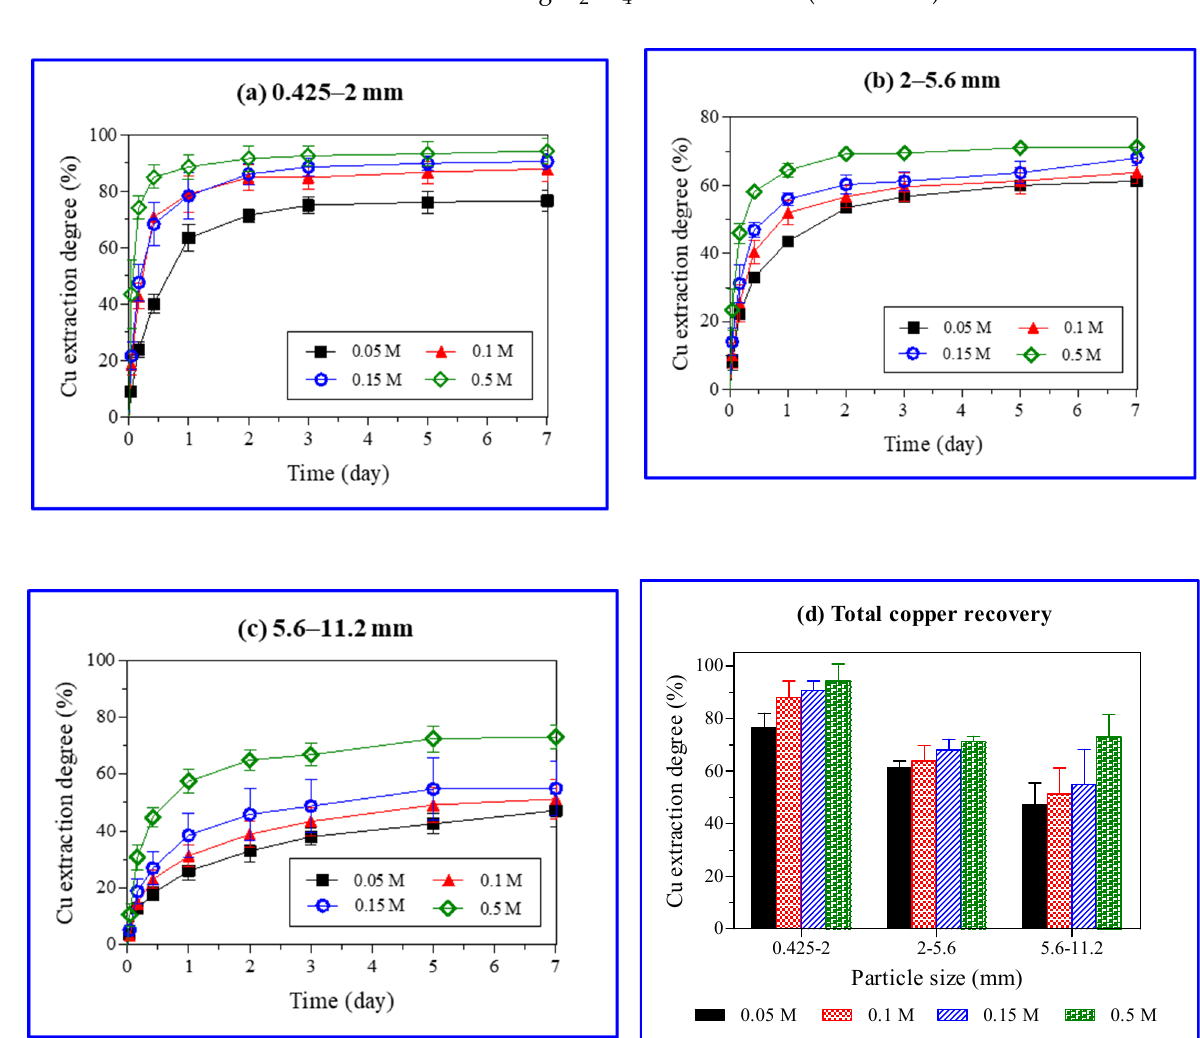
Figure 6. Effect of particle size and sulfuric acid (H 2 SO 4 ) concentration on copper extraction degree (%) with time ( a – c ) and total copper recoveries (%) after a weeklong (7 days) experiment ( d ).